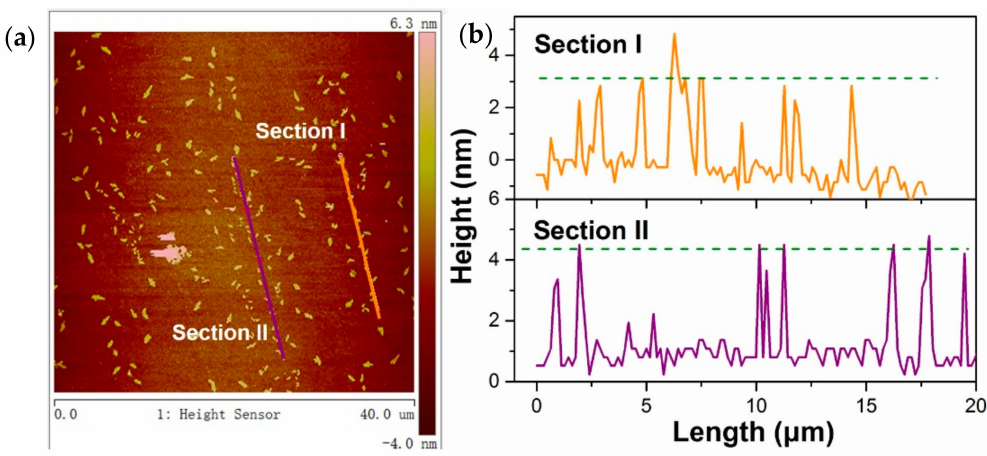
Figure 3. ( a ) Atomic force microscope (AFM) image of the 2H–TaSe 2 sample in a 40 × 40 µ m region and ( b ) correspond- ing